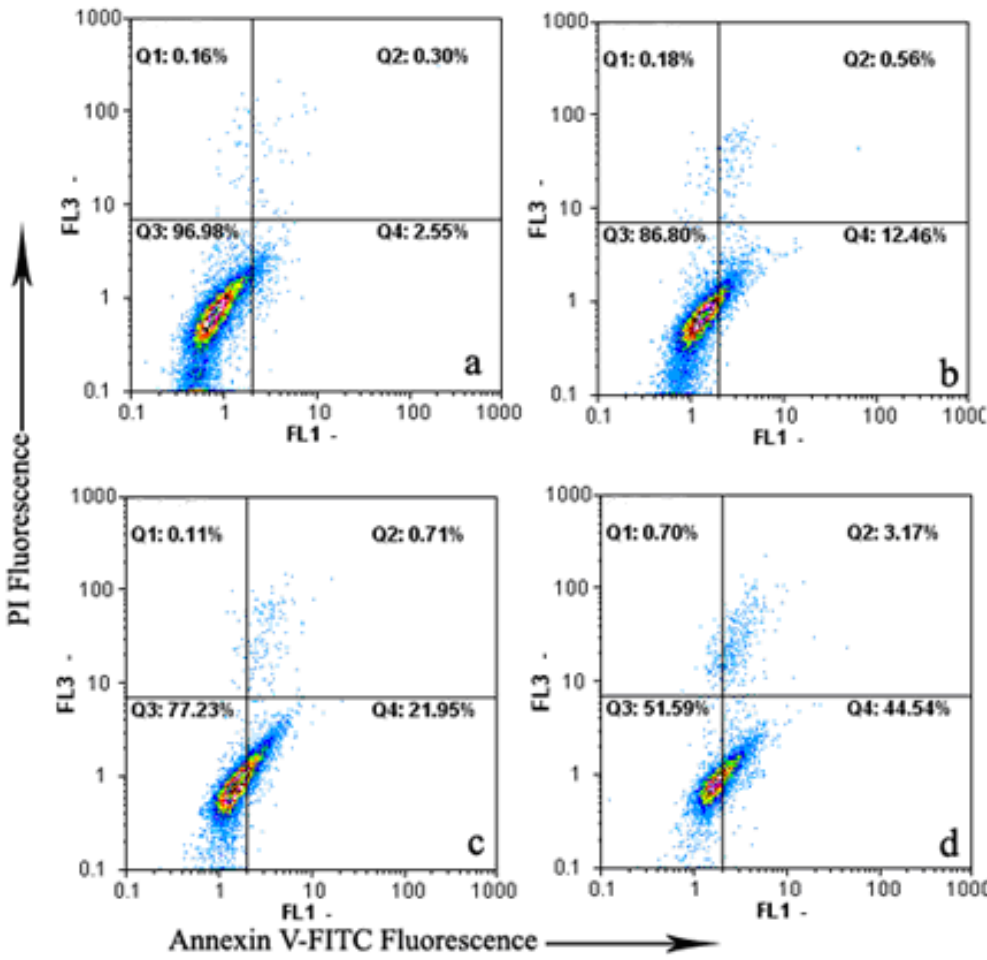
Figure 2. Daphnoretin-induced apoptosis in HOS using annexinV-FITC/PI. (a)-(d) Treatment with 0, 1, 2 and 4 μ M daphnoretin for 48 h, respectively. The experiments were repeated three times and representative photographs are